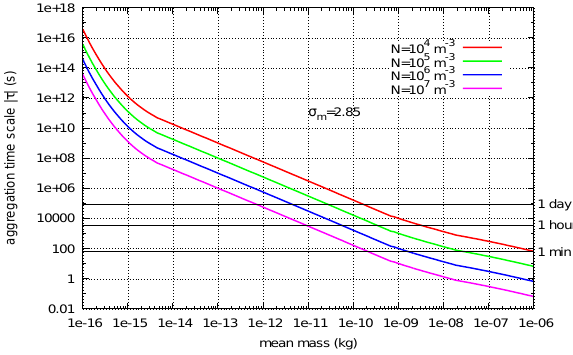
Fig. 3. Timescales of aggregation for a medium width of the ice Fig. 3. Time scales of aggregation for a medium width of the ice crystal size distribution ( σ m = 2 . 85) and for typical ice crystal num- crystal size distribution ( σ m = 2 . 85 ) and for typical ice crystal num- ber concentrations as found in cirrus clouds at cold temperatures ber concentrations as found in cirrus clouds at cold temperatures (see, e.g., Kr¨amer et al., 2009). The corresponding sizes range be- (see, e.g., Kr¨amer et al., 2009). The corresponding sizes range be- tween a modal length of 0.6 and tween a modal length of 0.6 and 8000 µ m.